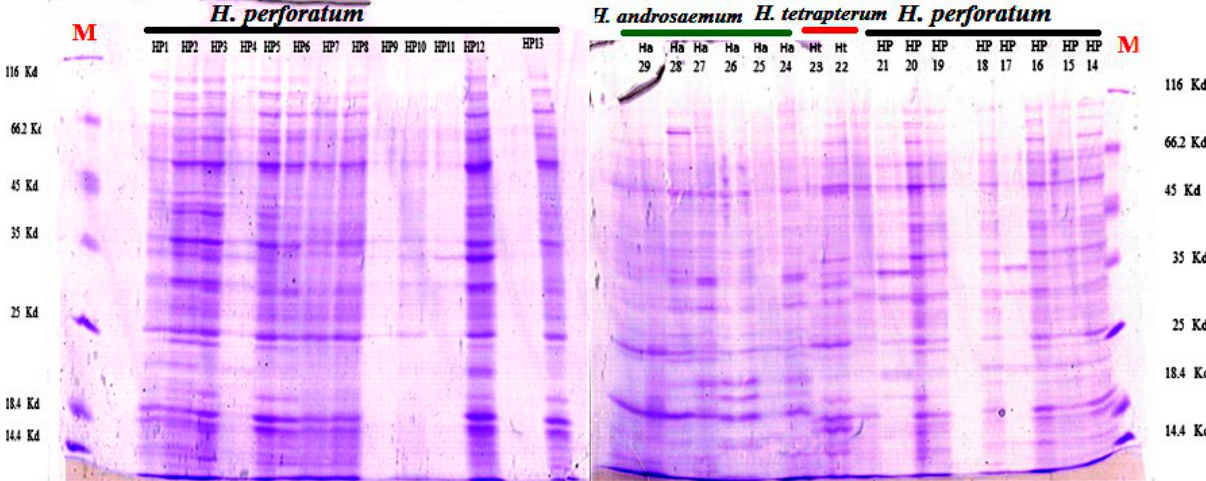
Figure 2. SDS-PAGE electrophoresis profiles of the studied population of Hypericum . Note: Populations abbreviations are according to Table